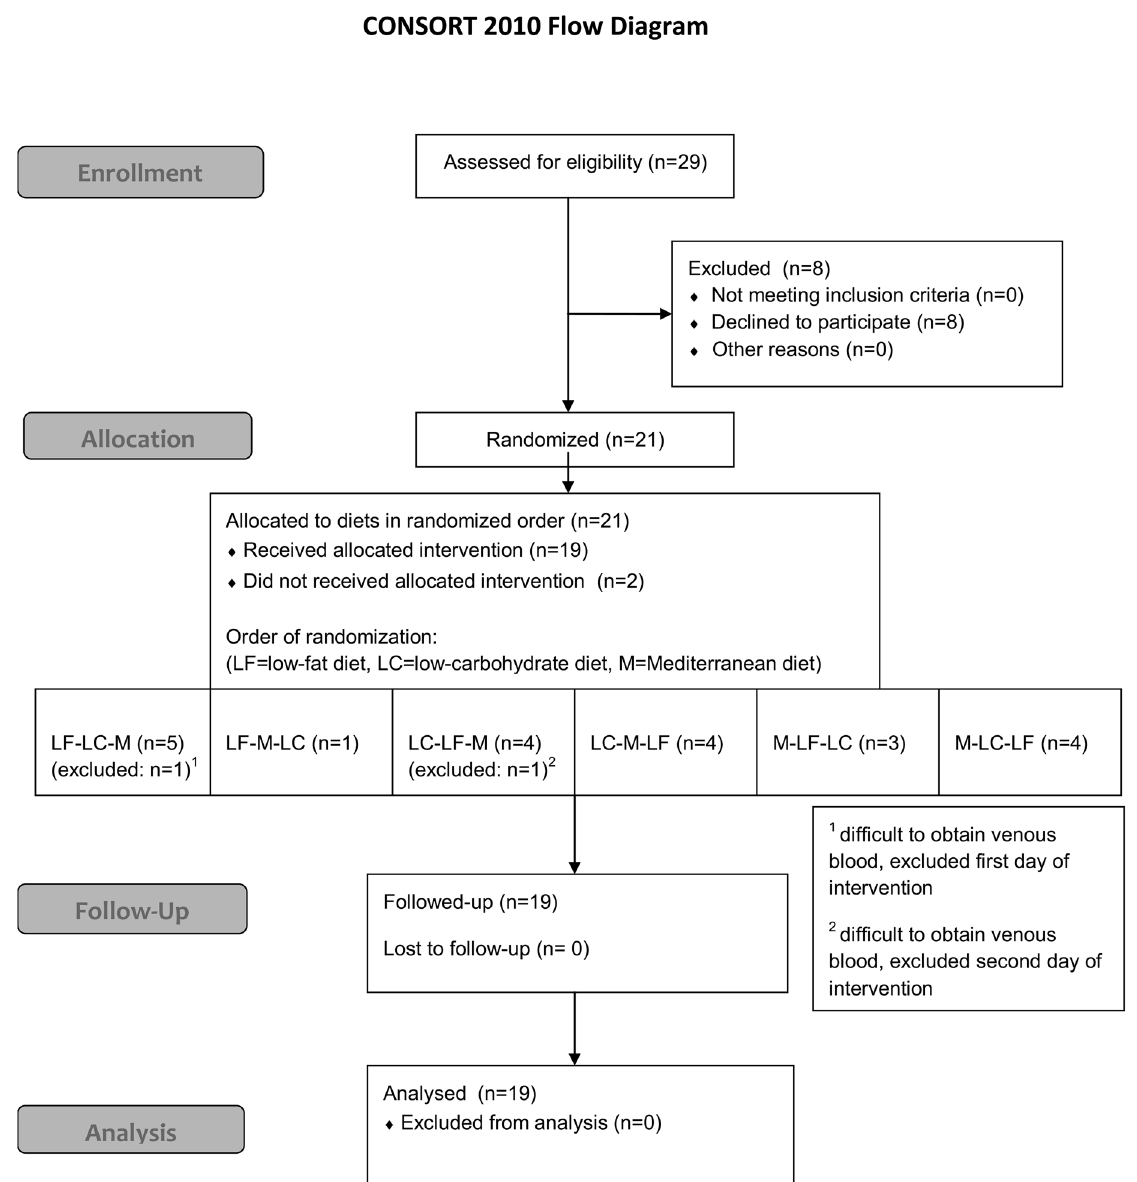
Figure 1. CONSORT Flow Diagram. Abbreviations: LF, low-fat diet; LC, low-carbohydrate diet; M, Mediterranean diet.